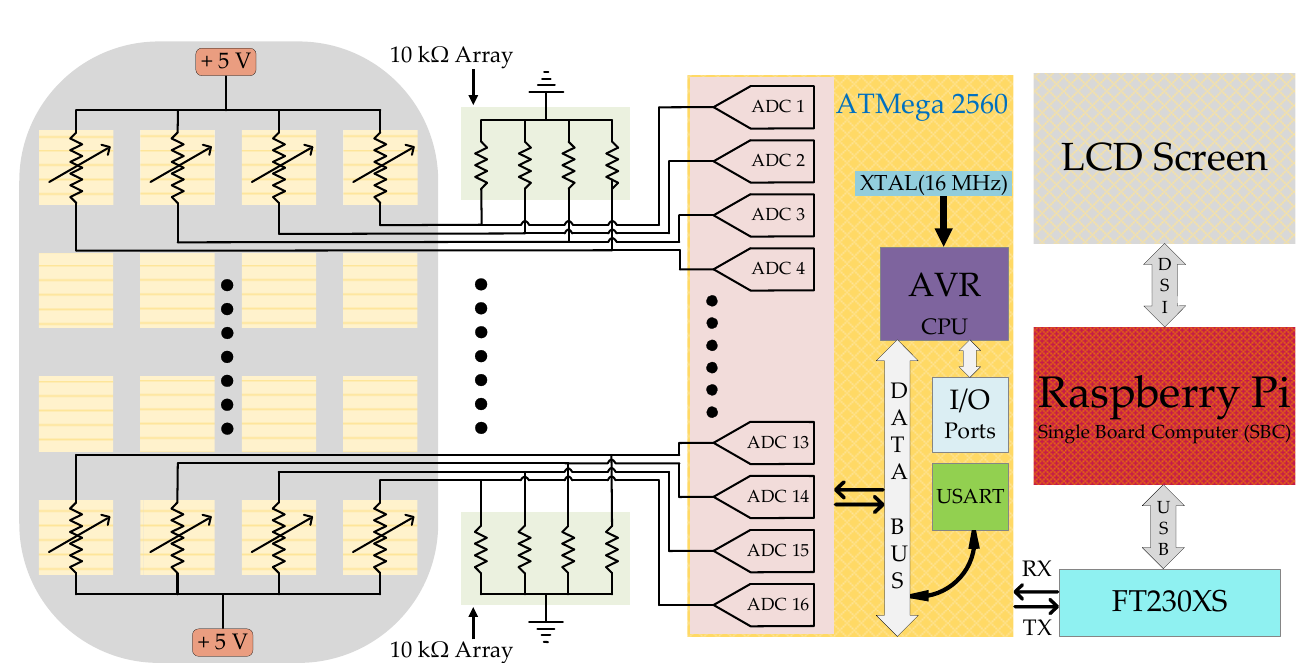
Figure 3. Explicit circuit model for standalone pressure sensing system.